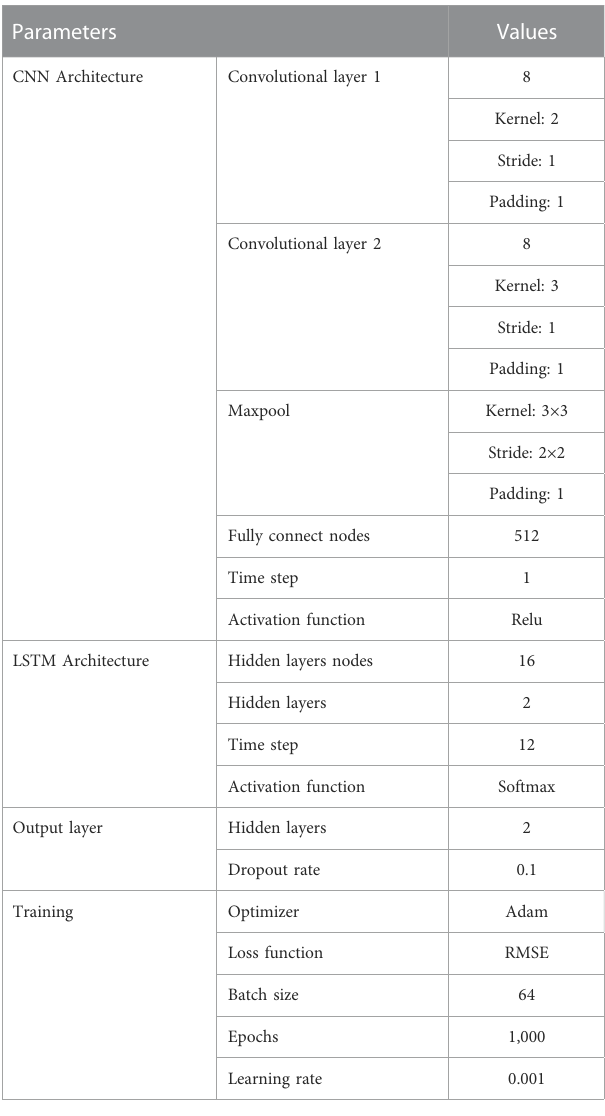
points are related to the location of the measurement points. The longer the period and the smaller the variation of target values of points closer to the downstream, while those closer to the upstream are not (i.e., the variation trend of target values at different measurement points is similar but not the same at any one time).